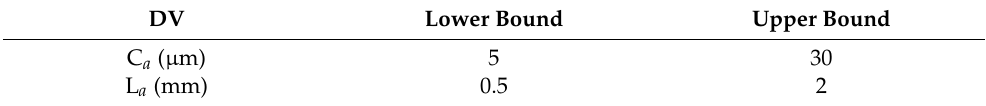
Table 2. DVs of optimization.